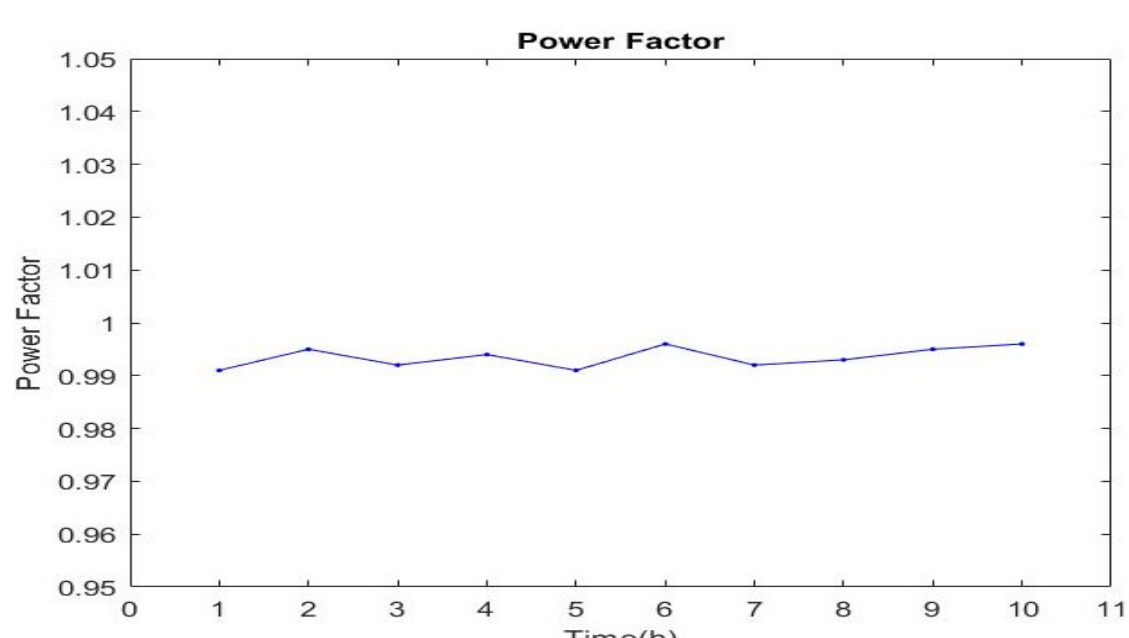
Figure 11. PWM signals for the switches.